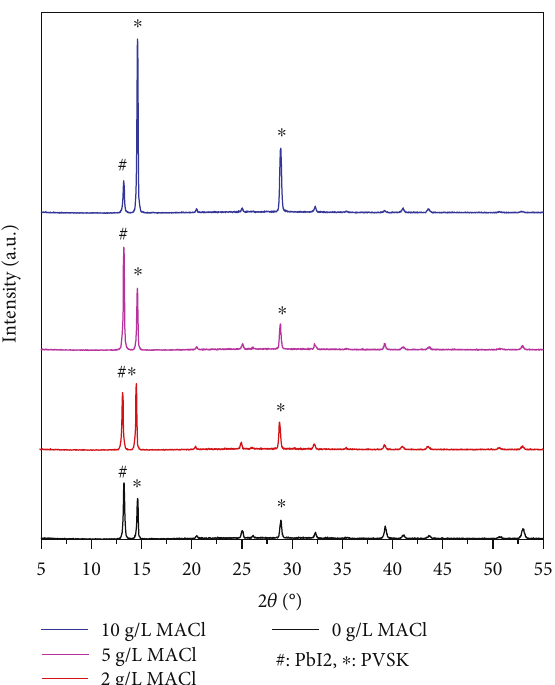
Figure 3: The XRD patterns of perovskite fi lms added di ff erent concentrations of MACl.